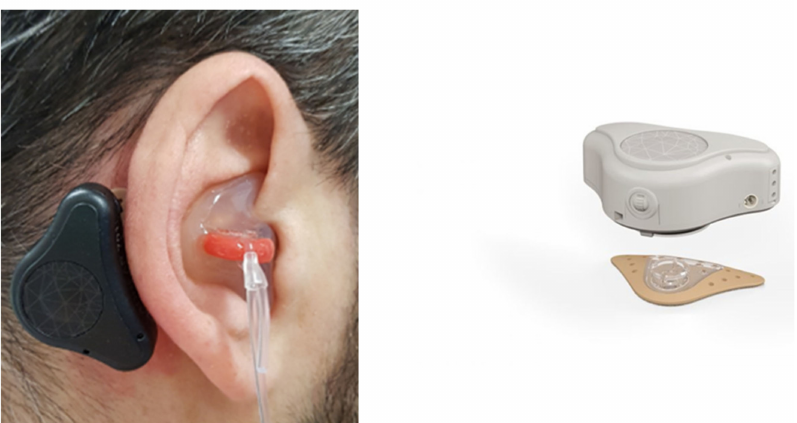
Figure 1. Right ear. ABCD device in place in a typical subject, where the ear canal is occluded by a custom silicone plug. On the right, a commercial figure of the ABCD showing the external laterale surface is visible, and the microphone ports are visible on the right (in the lower part of the device when worn on the right side).